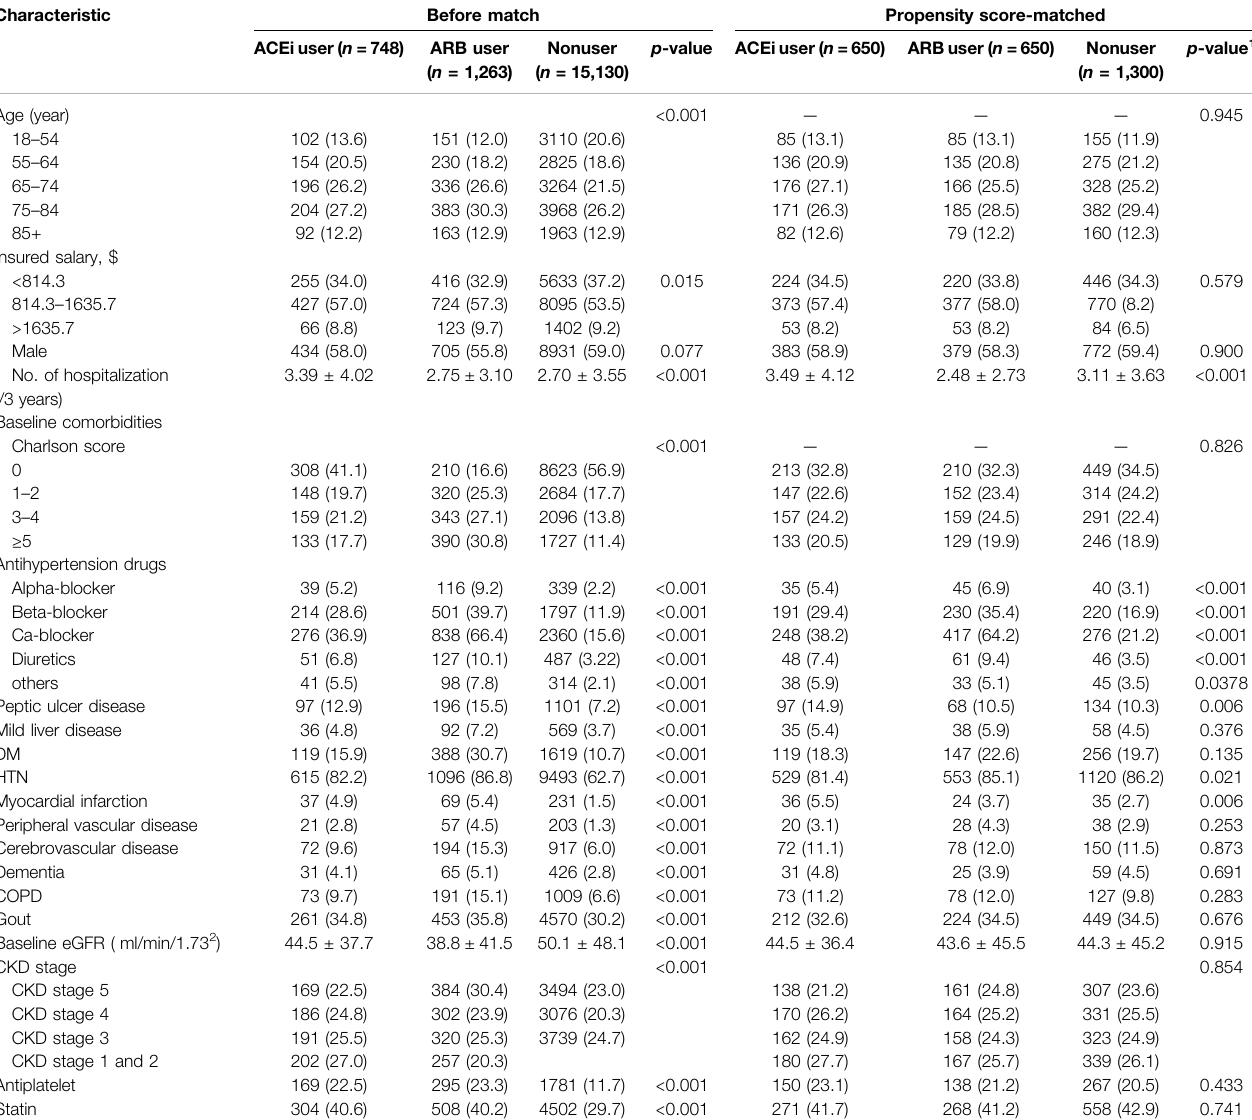
TABLE 1 | Comparison of patient baseline characteristics among ACEi users, ARB users, and other drug users. Characteristic Before